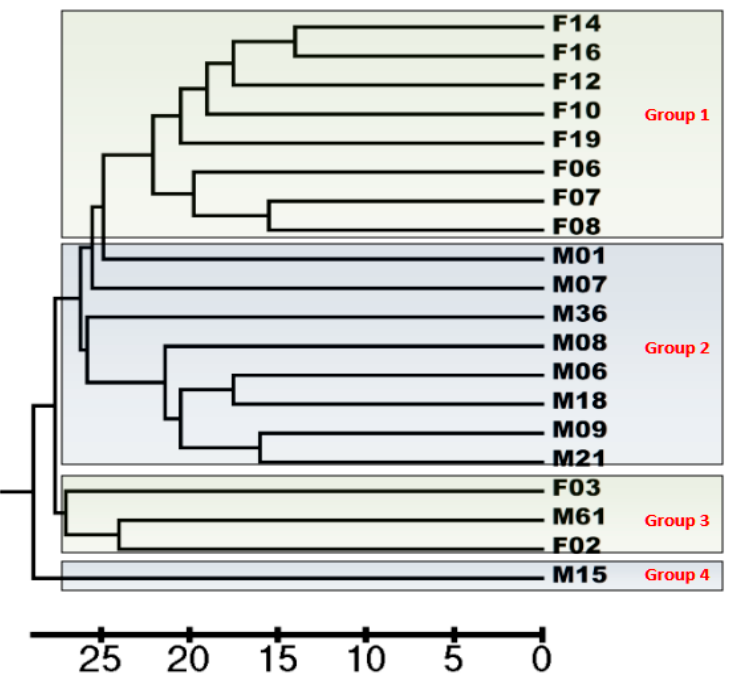
Figure 10. Dendrogram based on Nei [31] standard genetic distance using UPGMA method generated by eight ISSR primers among 20 P. lentiscus var. Chia genotypes, ten female and ten male, from Chios Island.